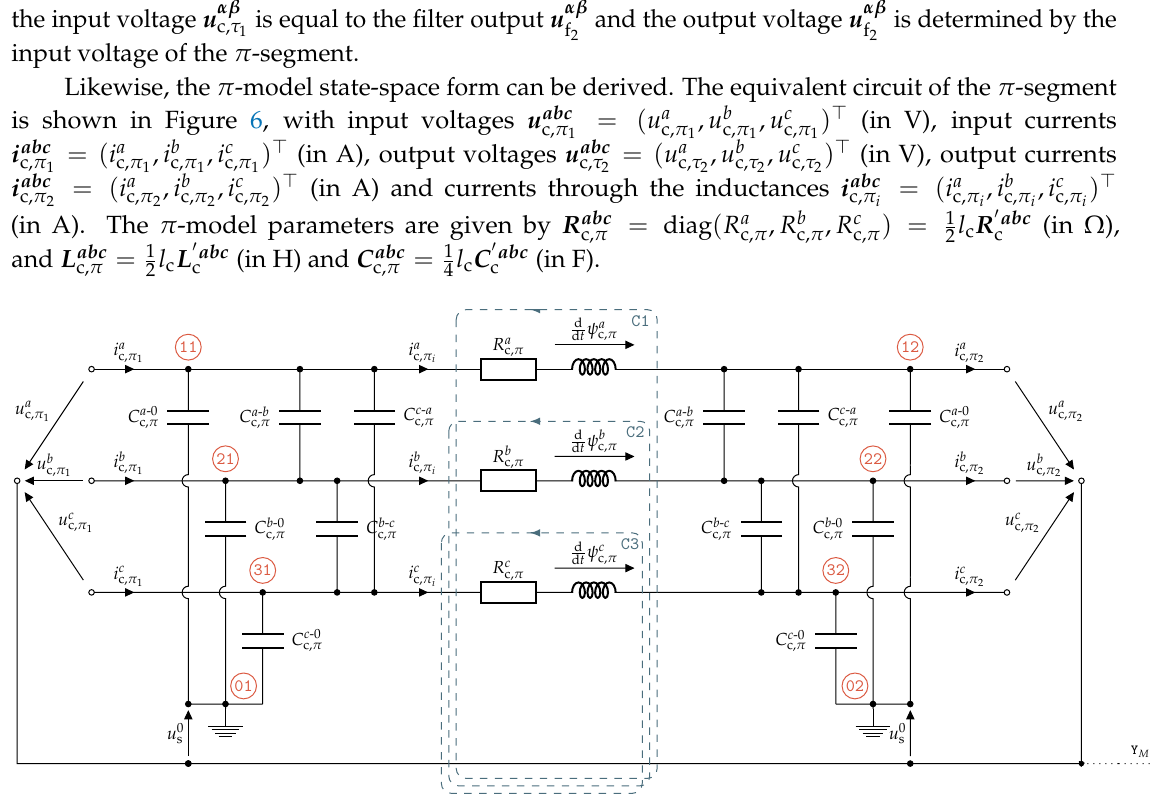
Figure 6. Equivalent circuit of the power cable π